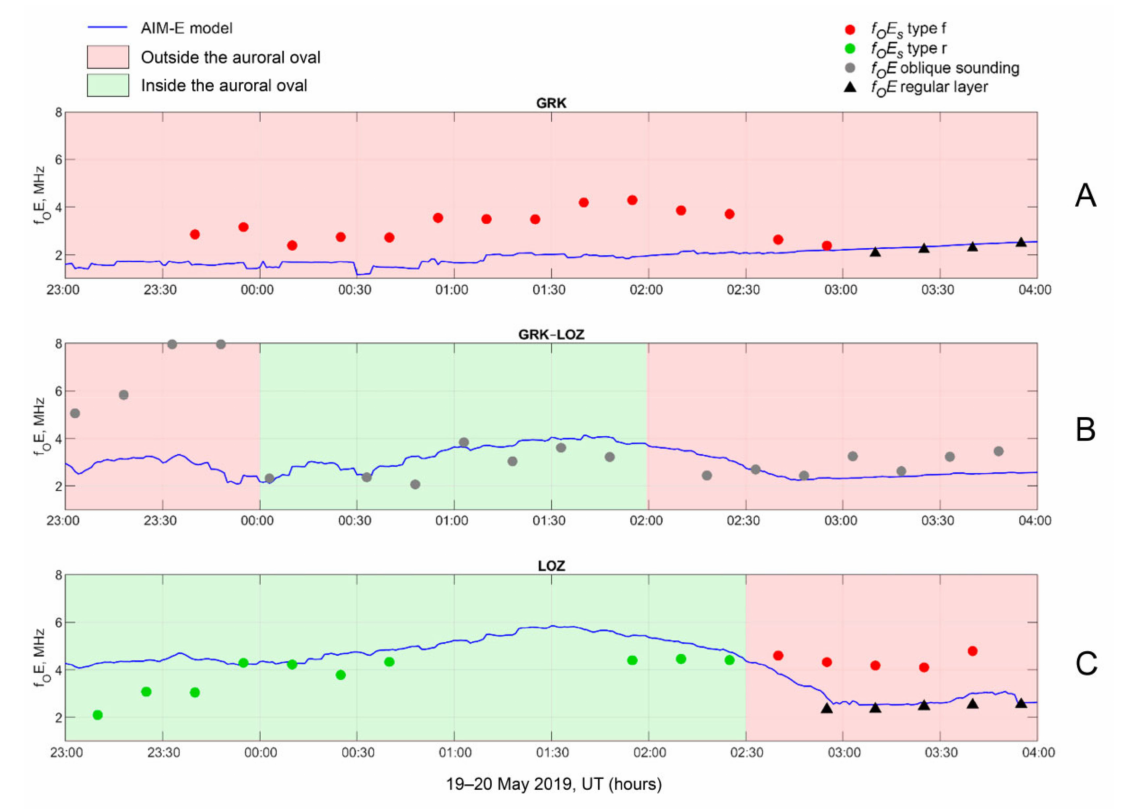
Figure 6. Comparison of the E layer critical frequencies obtained with vertical sounding method at Gorkovskaya ( A ) and Lovozero ( C ) stations, and with oblique sounding method at the central point of the Gorkovskaya–Lovozero radio path ( B ) with AIM-E simulation results (blue line) from 23:00 UT 19 May 2019 to 4:00 UT 20 May 2019. The time intervals are marked with a red background when the observation point was outside the auroral oval and with green inside the oval. Different types of observed layers are designated as follows: red dots—flat sporadic layer (type f), green dots—thick sporadic layer (type r), black triangles—regular E layer (f O E); gray dots—unknown, corresponds to oblique sounding method, which does not provide the information about the type of layer.